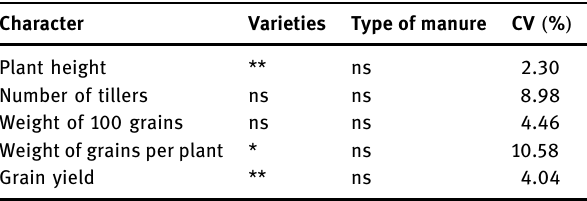
Table 2: Analysis of variance for each